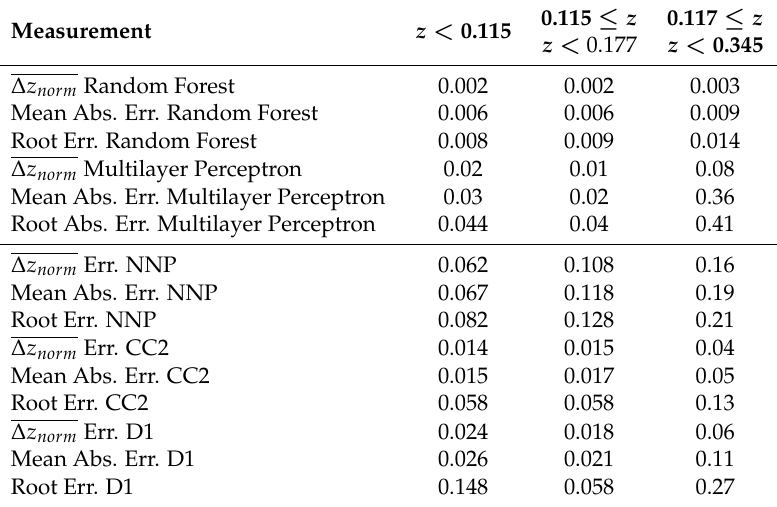
Table 5. Error of the different photometric redshift algorithms in different redshift